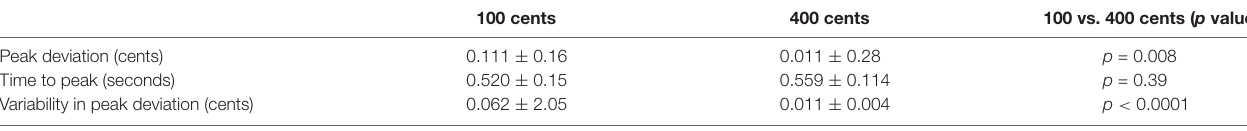
TABLE 1 | Pitch production during perturbations.